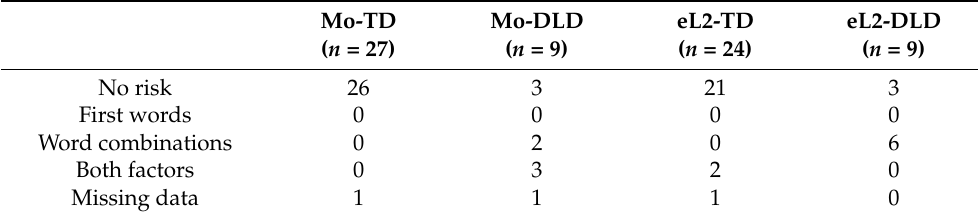
Table 3. Number of children affected by the risk factors per